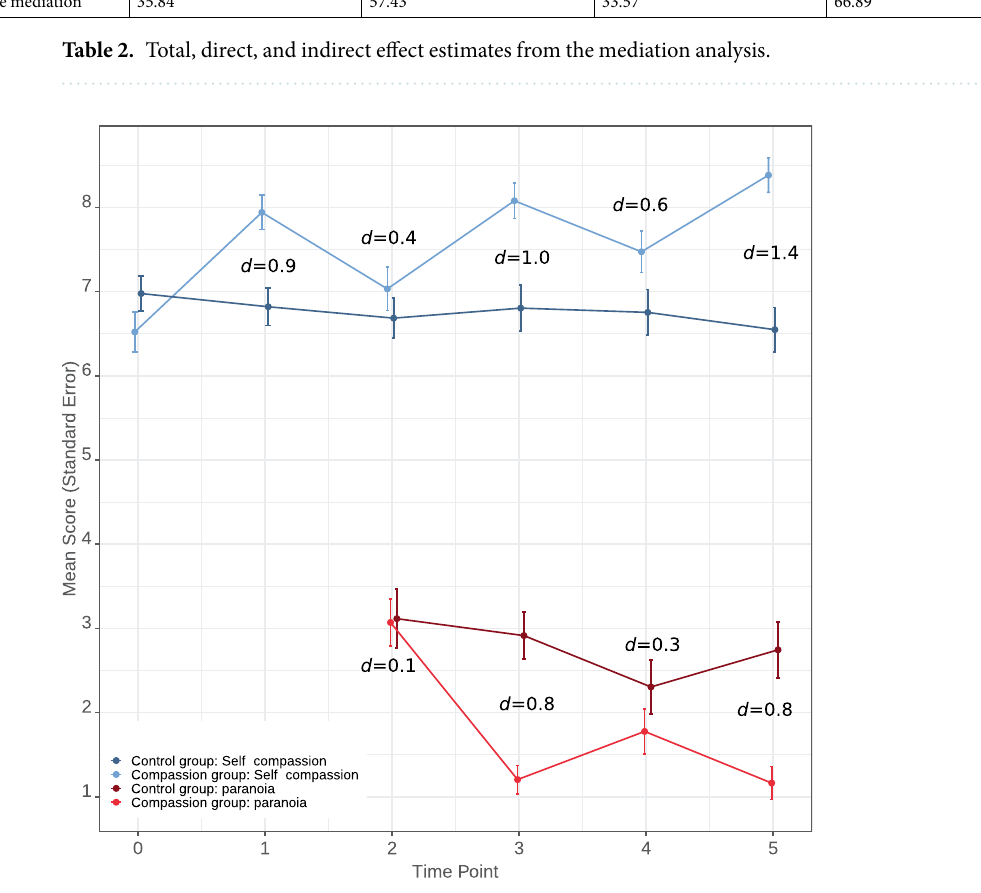
Figure 2. Scores and effect sizes for primary compassion and paranoia outcomes (study one).